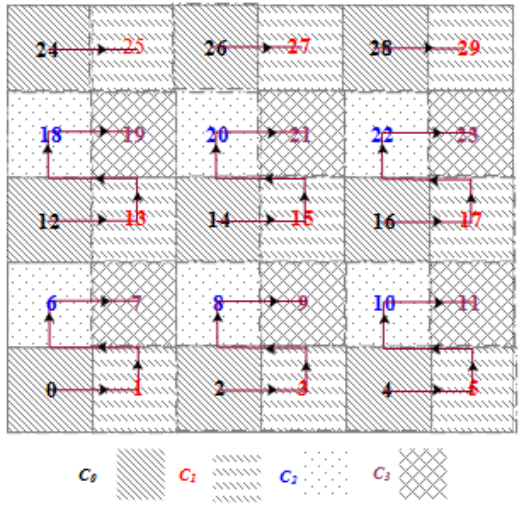
Figure 4. Slot assignment using algorithm 2 (GCA). Algorithm 2. Conflict free TDMA frame slot assignment GCA (implemented at each SH